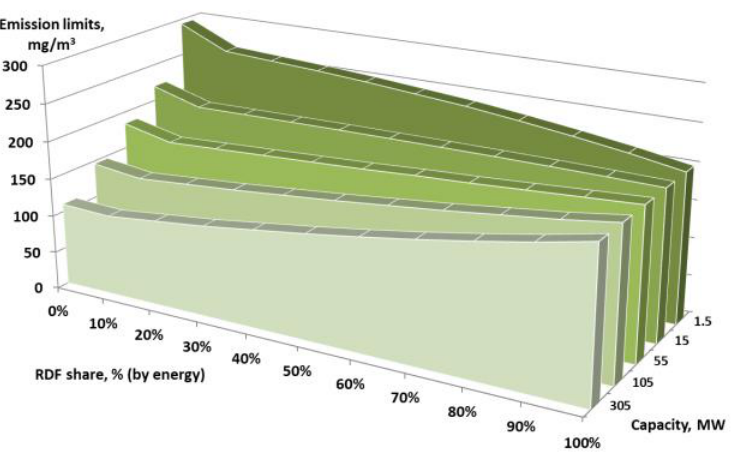
Figure 4. The impact of the installation capacity and share of RDF on the NOx emission limits (re- quired values based on the EU Directives and BAT